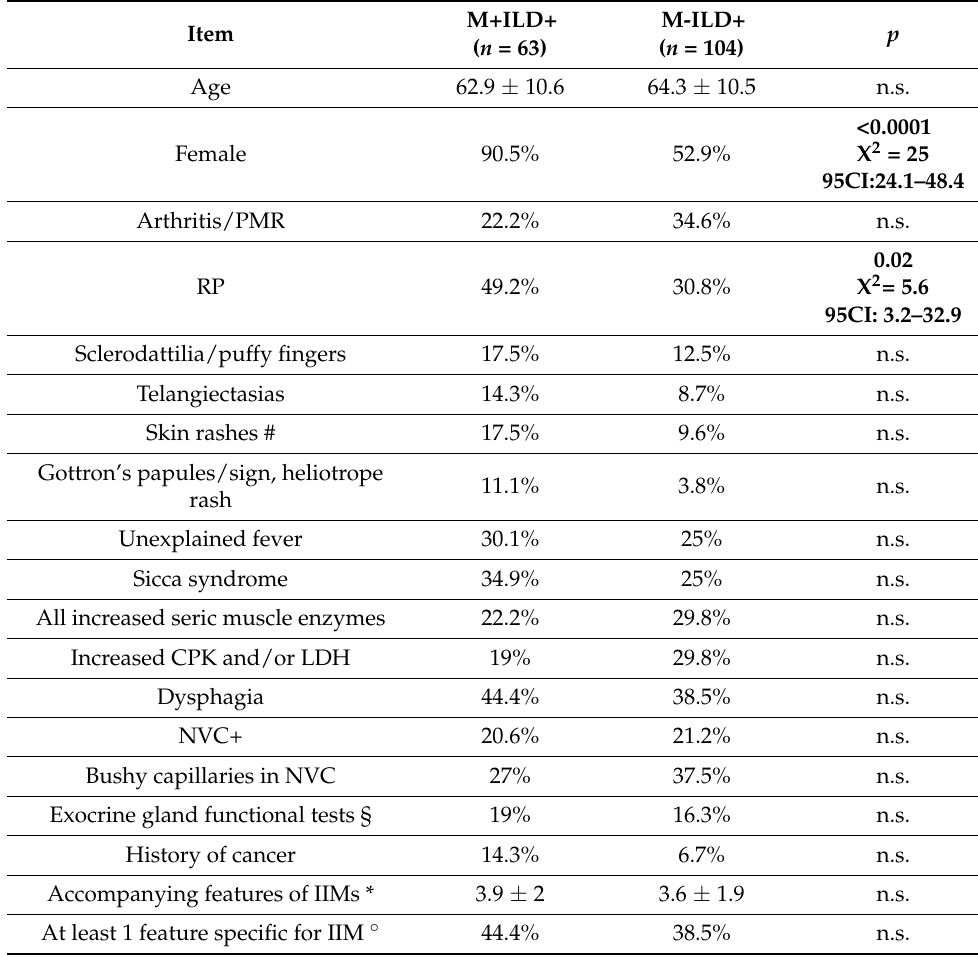
Table 1. Clinical Presentation of ILD